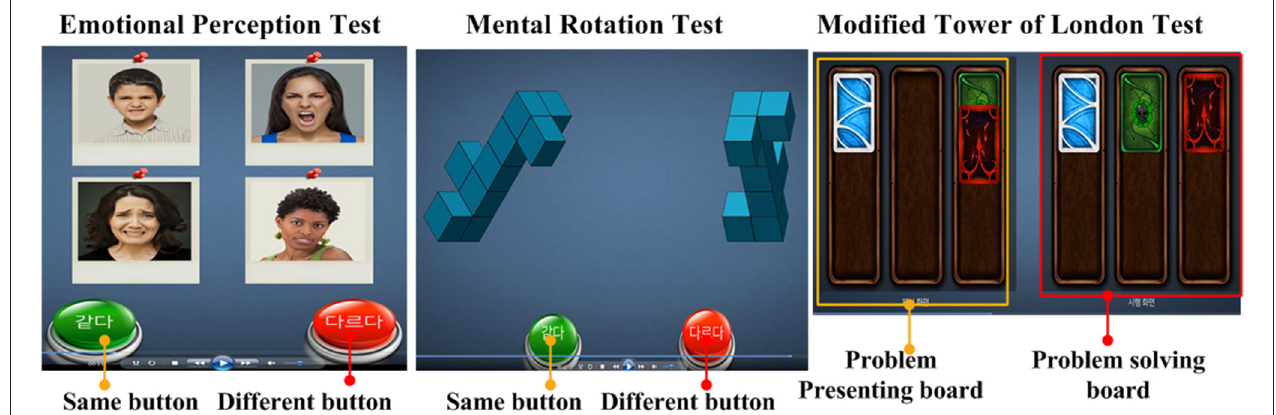
FIGURE 1 | Neurocognitive function test. The images were obtained from the neurocognitive function test manufacturer MBI ® (https://www.mbi-clinic.center/).